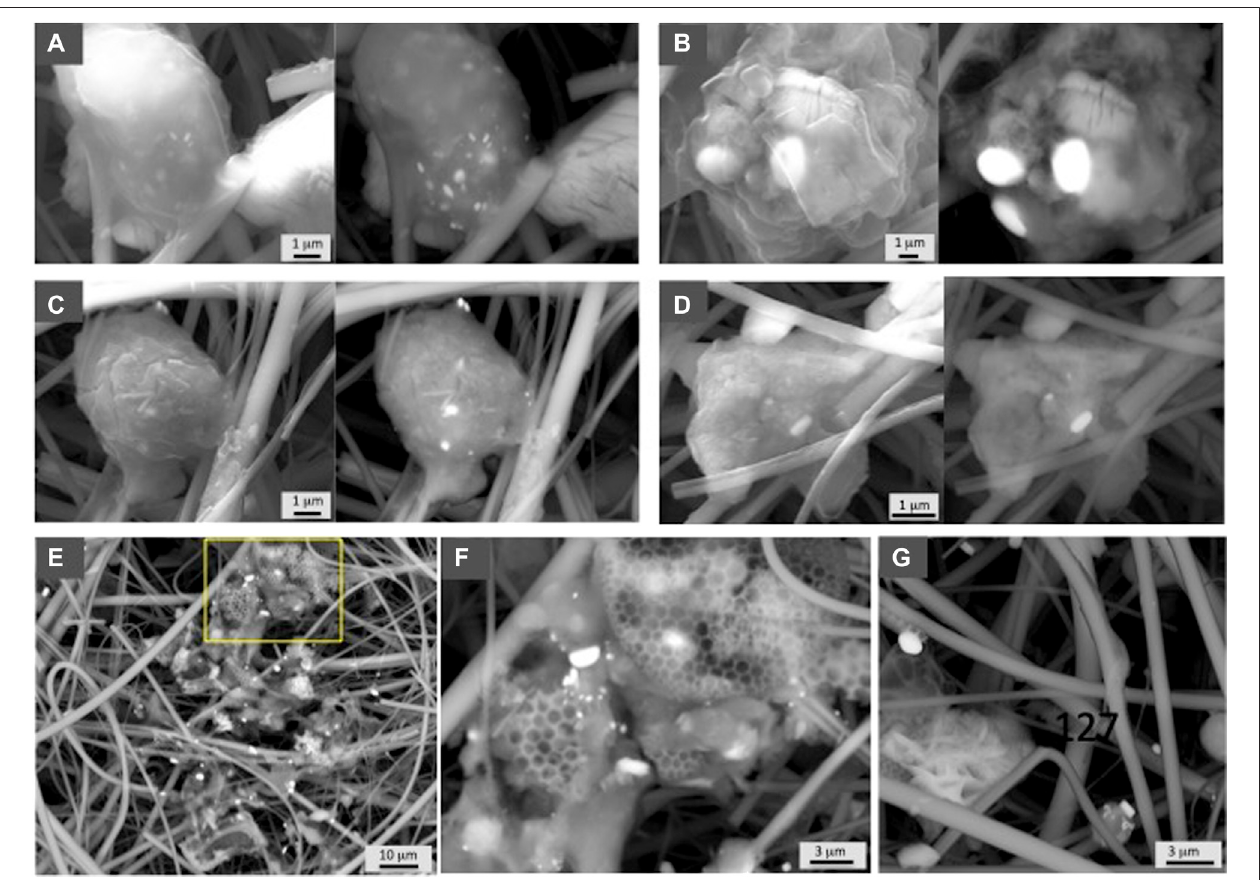
FIGURE 3 | SEM photographs showing representative examples of barite from the Atlantic sector analyzed in this study. Samples are indicated in Table 1 . Both secondaryelectron and inbackscattered electron (BSE) mode at 30 kV areshown ineach sample. (A) GCM122(112 m), (B) GCM123(162 m), (C) GCM124(300 m), and (D) GCM 126 (750 m). (E) GCM 125 (500 m) shows the barite abundance at 500 m depth, and (F) GCM 127 (1,000 m) shows a detailed image of the square indicatedinphotographe,inwhichdifferentsizesofbaritegrainsareshowninorganicaggregates. (G) GCM127correspondstothedeepest fi ltersampleobtained at this ocean sector, 1,000 m, in which barite is not abundant but still